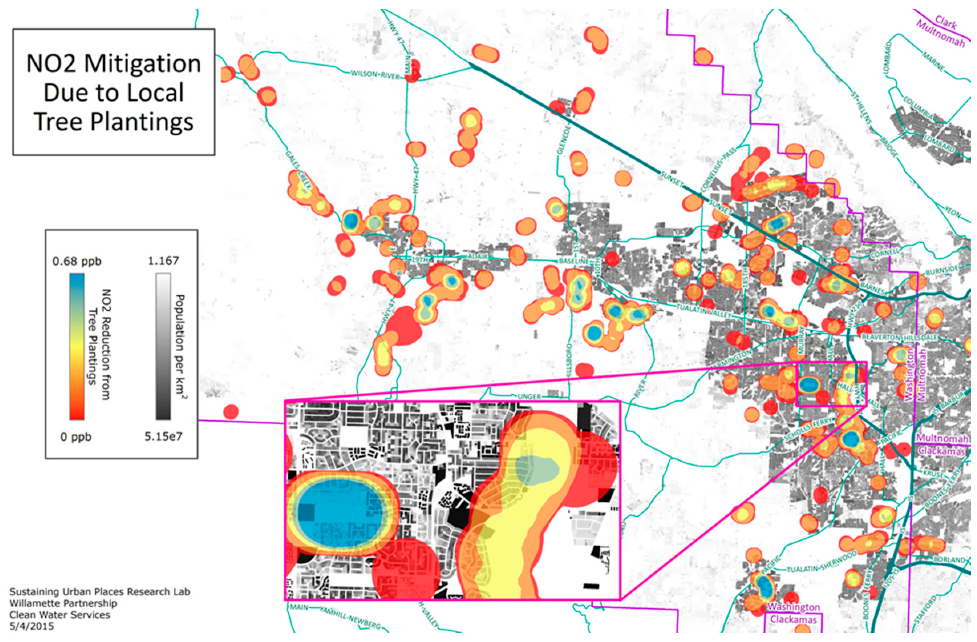
Figure 3. NO 2 reduction associated with Clean Water Service (CWS) planting sites (35 year projection).